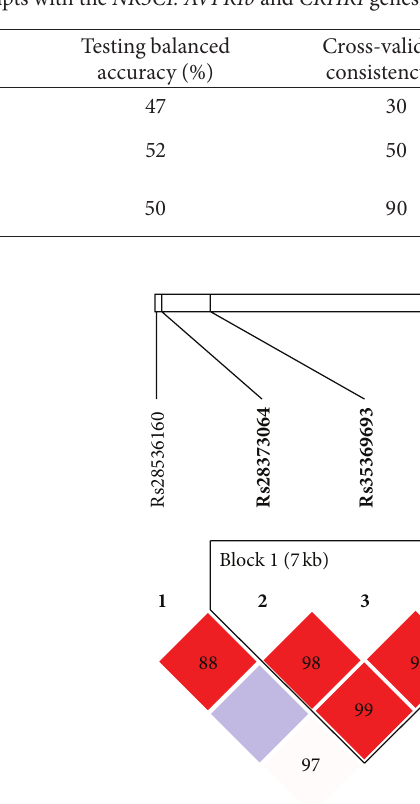
Table 7: Multilocus interaction model for the risk of suicide attempts with the NR3C1. AVPR1b and CRHR1 genes by the MDR method.